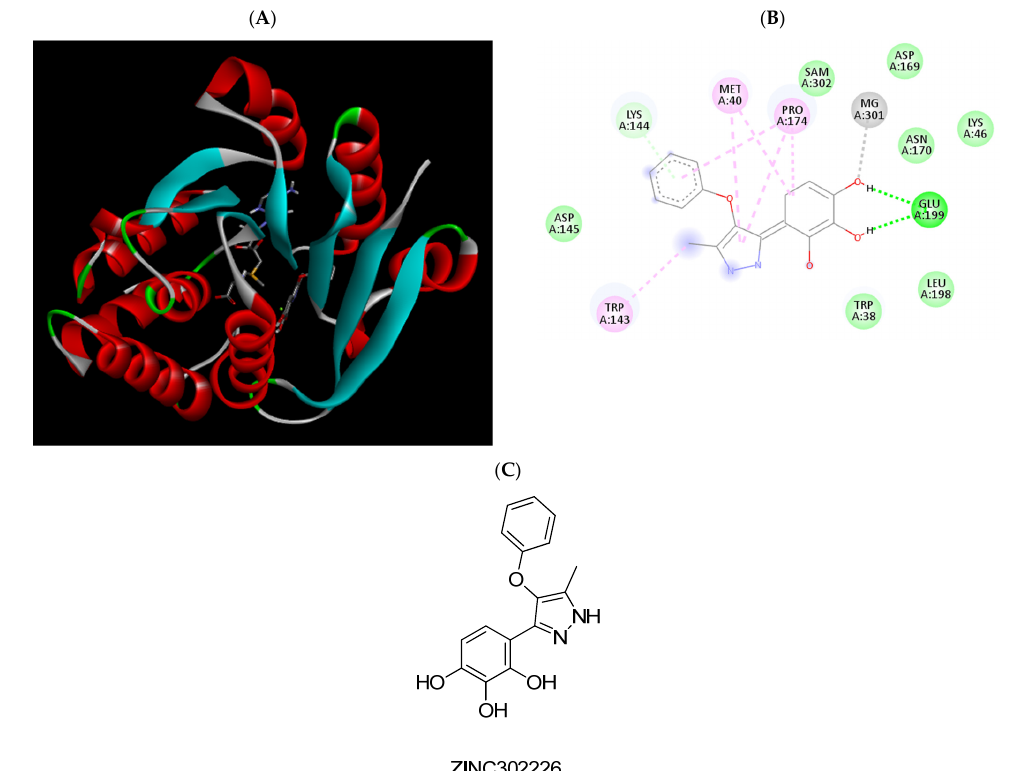
Figure 7. ( A ) Binding modes of ZINC302226 with the crystal structure of human COMT complexed with SAM and Mg 2+ , ( B ) receptor–ligand interactions, ( C ) 2D representation of ZINC302226